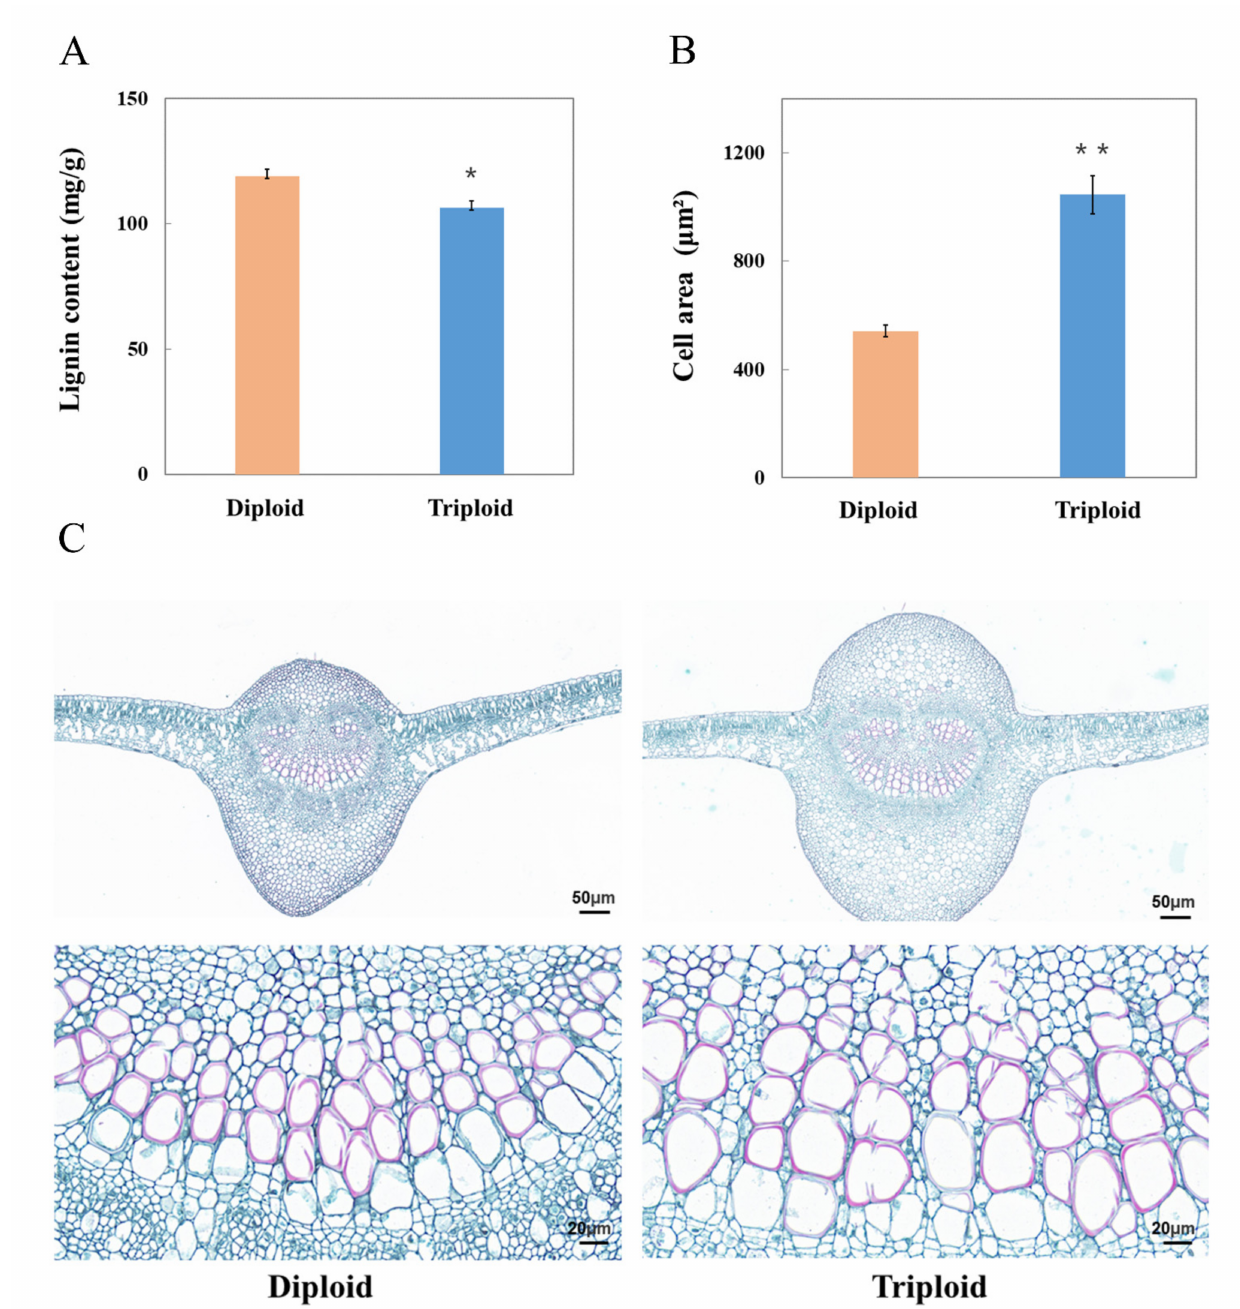
Figure 1. Analysis of lignin content in triploid and diploid leaves. ( A ) Lignin content in triploid and diploid leaves. ( B ) Cell area measurement of triploid and diploid xylem vessels. ( C ) The observation of xylem cells in triploid and diploid leaves. Values are the means ± SE of three independent experiments. The asterisk indicates significant differences (* p < 0.05, ** p < 0.01). Bar = 50/20 µ